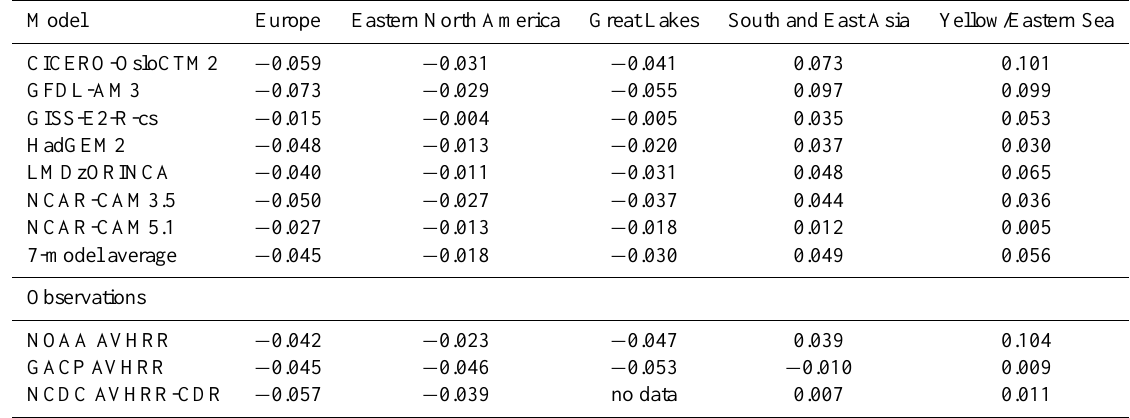
Table 6. Comparison of regional trends in AOD (550nm) from ∼ 1980 to ∼ 2000 with AVHRR observations (630nm) over water. Model Europe Eastern North America Great